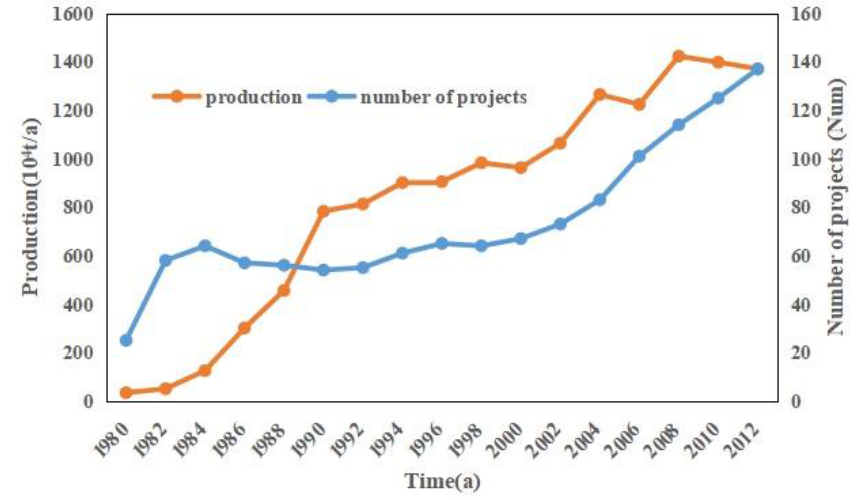
Figure 3. The number of projects and production of CO 2 flooding in United States. At high-pressure conditions beyond the critical pressure, as the pressure increases, CO 2 becomes a liquid, sticky substance. CO 2 is more soluble in water than general hydrocarbon gas, and its solubility in crude oil is greater than that in water, so CO 2 can be